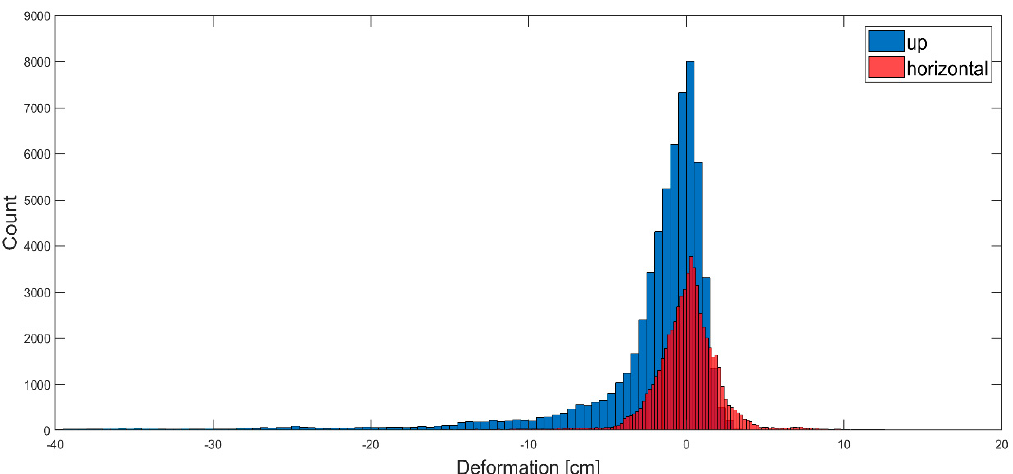
Figure 8. The histograms present the vertical (blue) and horizontal (red) displacements (in meters) that were retrieved by using the proposed method (Kriging integration). The drawing is cut off on the left to improve the layout. In fact, there are also single deformations that reach about one meter.